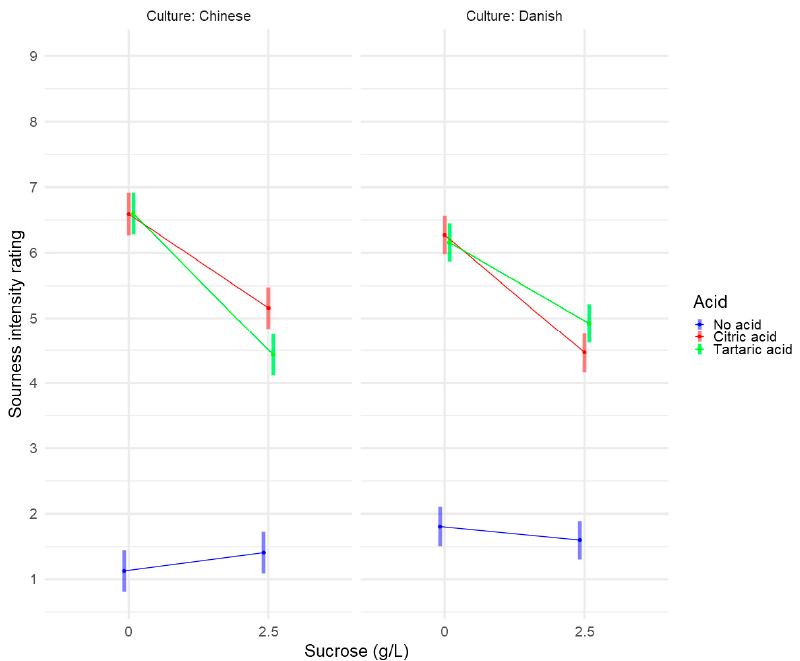
Figure 3. Interaction plot showing the means of the interaction between acids and sucrose for sourness intensity rating for Chinese and Danish consumers, respectively. Means are full dots. Surrounding faded lines indicate 95% confidence intervals.